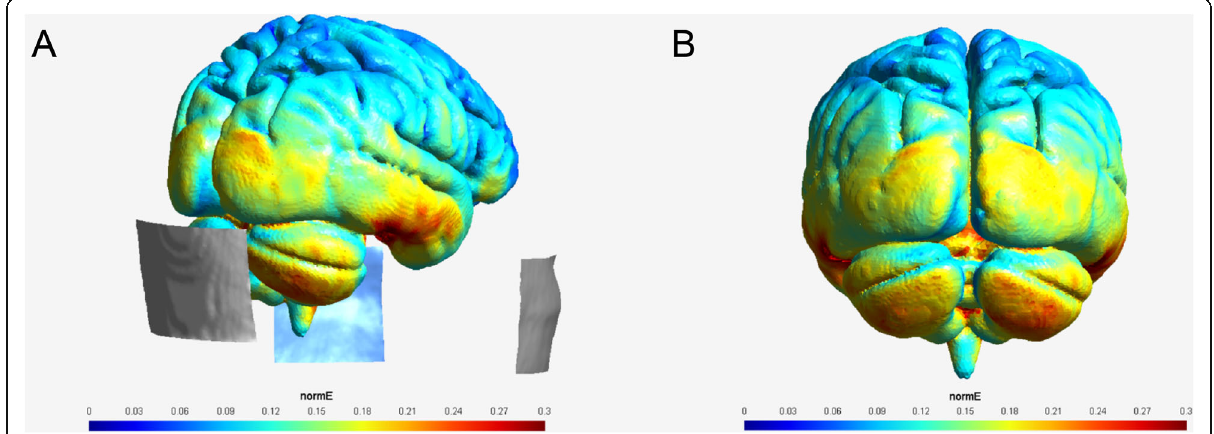
Fig. 2 Modelling results of cerebellar tDCS effects. Distribution of normEF values (V/m) calculated using SimNIBS overlayed on an average brain in the age range of 55 – 50 years [taken from Neurodevelopmental MRI Database [30]; https://www.nitrc.org/projects/neurodevdata/]. a Lateral view, showing also the target electrode over the cerebellum and return electrodes over the buccinator muscles. b View from the